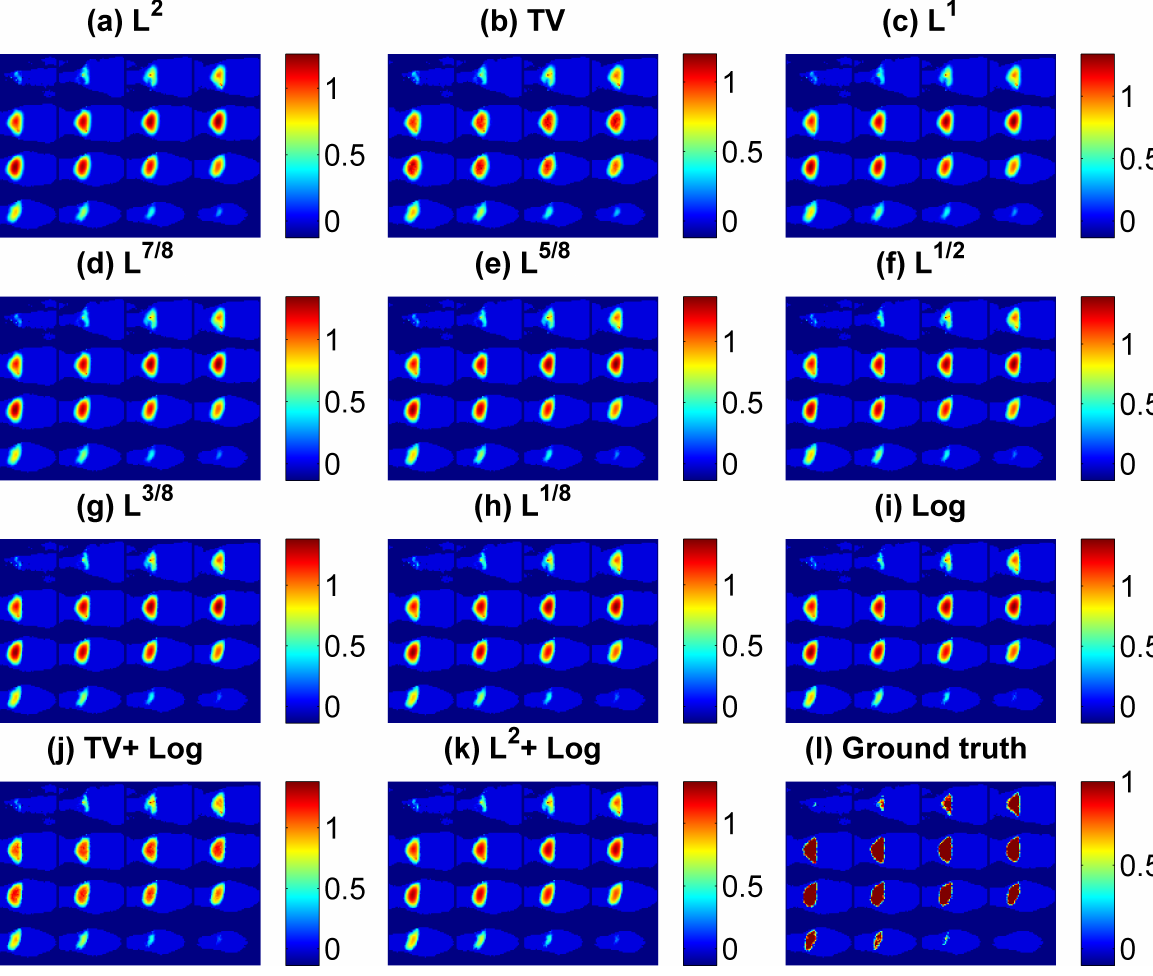
= 1.0E-3, 2 = 1.0E-3, 7 / 8